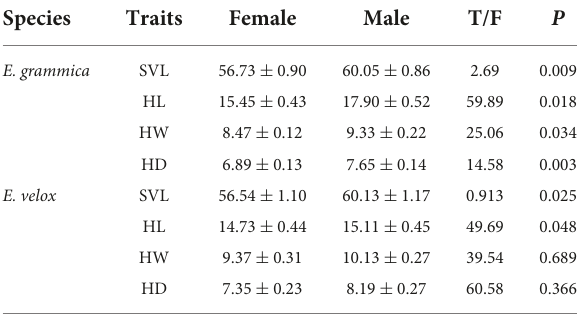
TABLE 1 Sexual dimorphism of Eremias grammica and E. velox (mm).